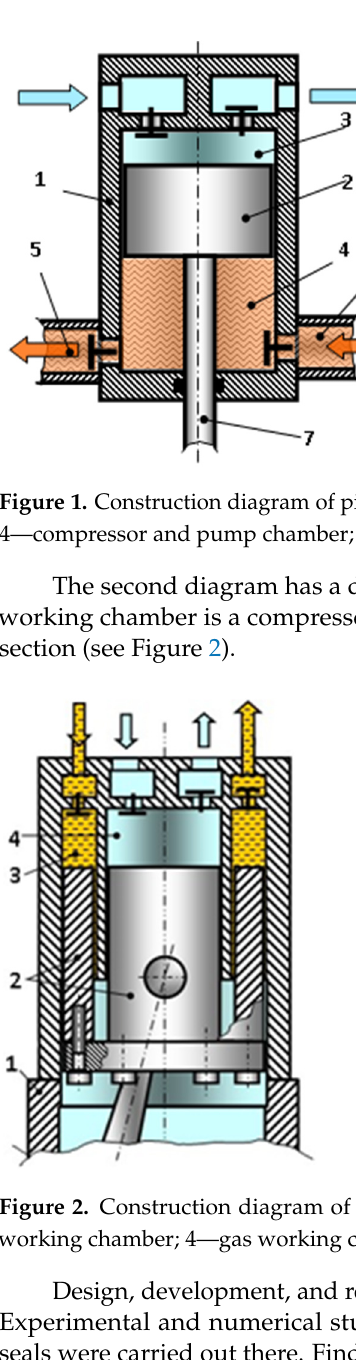
Figure 2. Construction diagram of crosshead-free PHPM (1—crankcase; 2—piston; 3—pumping working chamber; 4—gas working chamber).